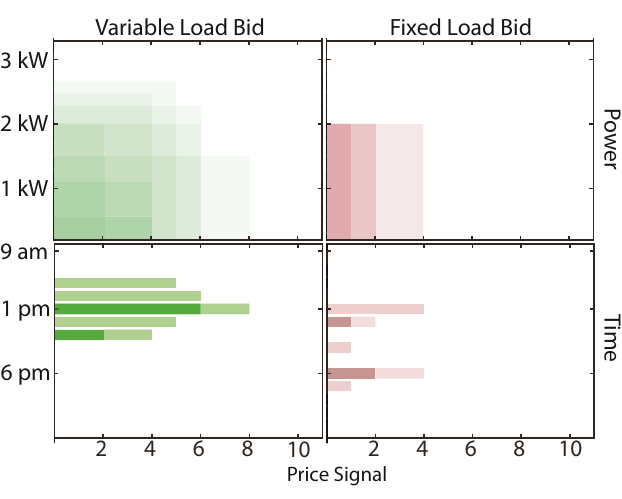
Fig. 9. Bid generated with nvParam by Flexometers and their turn ON timings during demonstration with respect to price